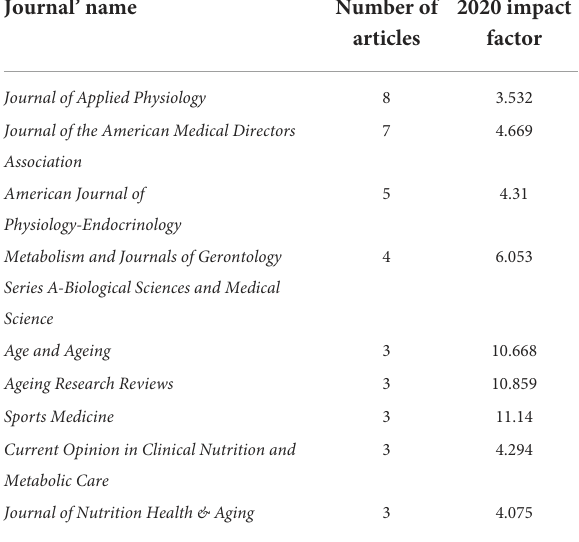
TABLE 2 Top-cited articles according to journal and their impact factors (only journals with 3 or more articles have been shown).